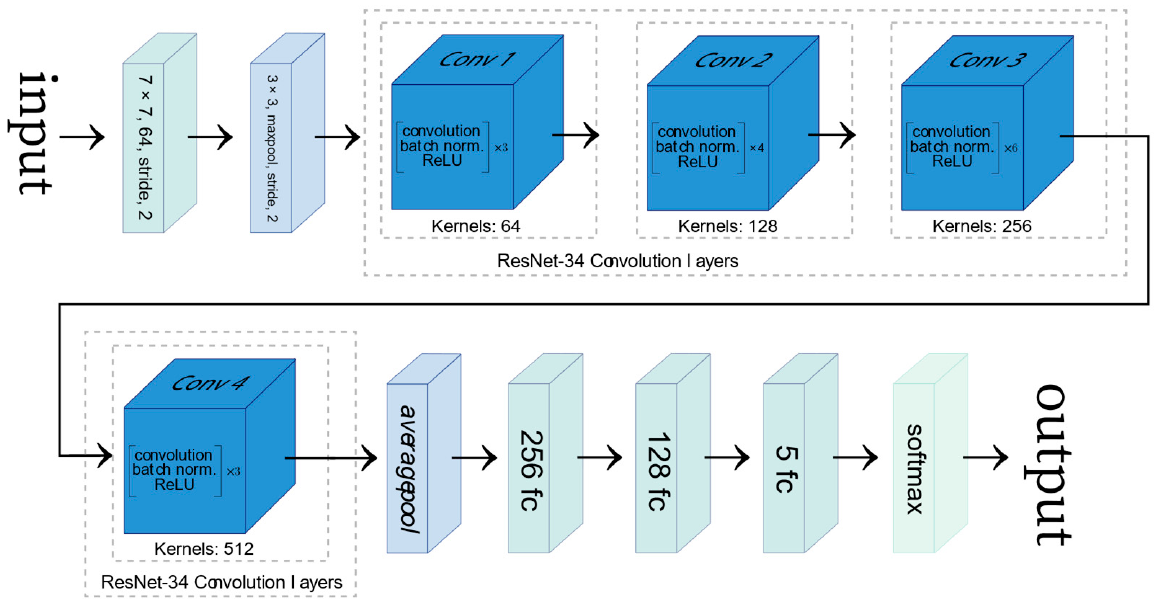
Figure 1. Representation of the ResNet-34 architecture modified with two fully connected (FC) layers added. The figure was adapted from [28].